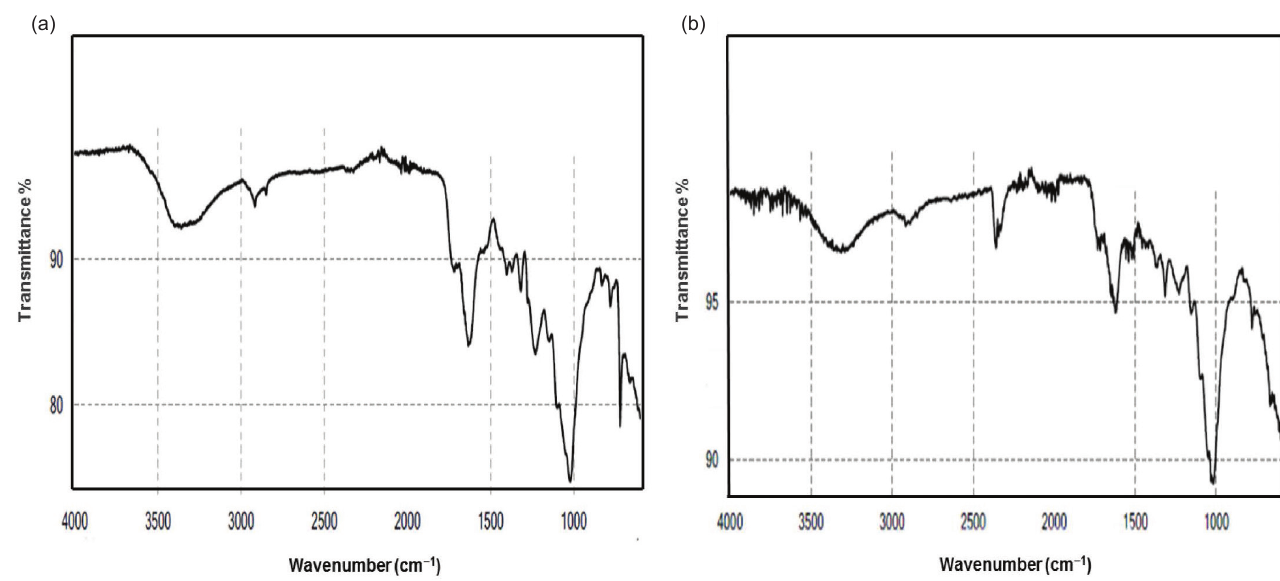
Fig. 6 – FTIR spectrum of Oxalis (a) before adsorption of SR 3BL; (b) after adsorption of SR